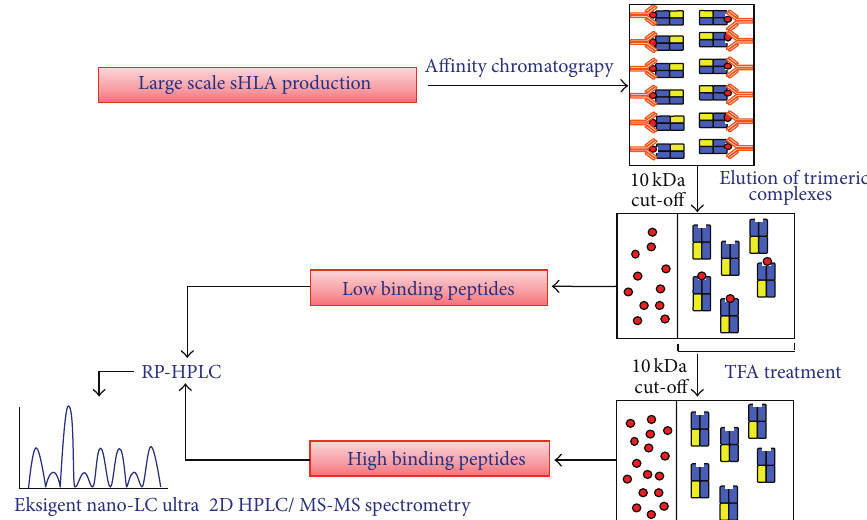
Figure2:GenerationofpeptidesequencesfromsHLAmolecules.Thisfiguregivesaschematicoverviewofthestepstowardsthegenerationof peptide sequences obtained from sHLA molecules. The HLA heavy chain is given in blue; 𝛽 2m is shown in yellow; and the peptide is shown in red. Cell culture supernatants containing sHLA molecules are passed over an N-hydroxysuccimide- (NHS-) activated HiTrap column coupled to mAb w6/32. Trimeric complexes (class I heavy chain, 𝛽 2m and peptide) are eluted using a pH 2.7 elution buffer. Here, peptides from sHLA complexes can be differentiated into low and high binding peptides. The trimeric elution fractions are filtered through a 10kDa cut-off membrane and the peptides detected in the flow through are considered to be of low affinity. The retentate containing dimeric (heavy chain and 𝛽 2m) as well as trimeric complexes is then treated with 0.1% trifluoroacetic acid (TFA) to elute high binding peptides that can finally be separated by filtration through an additional 10kDa cut-off membrane. Flow through fractions containing the low or high affinity peptides are subjected to mass spectrometric analysis using an Eksigent NanoLC Ultra 2D HPLC coupled to an orbitrap ion trap. Database queries can finally be carried out using Mascot software [25] incorporating the IPI human and the respective decoy